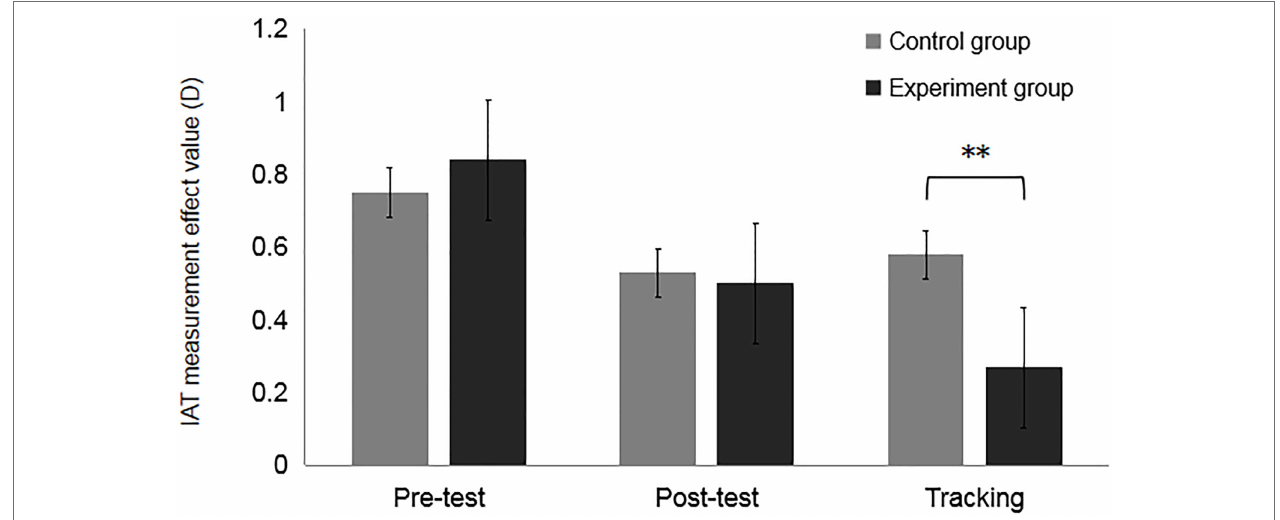
FIGURE 5 | Results of the measurement of the effect value (D) of the training effect for different groups, ** p <